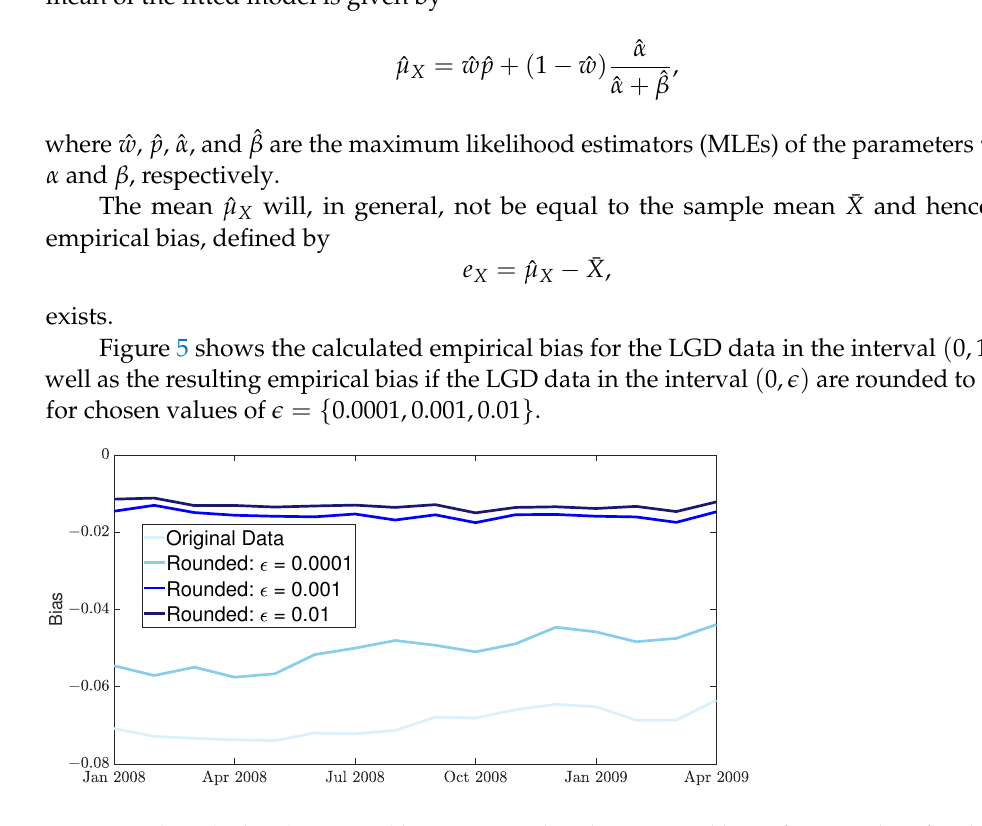
Figure 5. The calculated empirical bias compared to the empirical bias after rounding for chosen values of (cid:101)